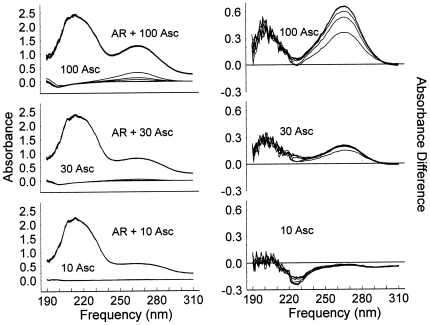
Spectroscopic measurements of ascorbate-human adrenergic receptor binding.The figures on the left show the superimposed records of six spectra collected 118, 141, 155, 188, 199, and 228 minutes after the samples were prepared. Samples with both AR and ascorbate are indistinguishable from one another and do not change over time, while the ascorbate alone samples show ascorbate oxidation and a decrease in absorbance in the 266 nm range. The difference spectra in the right hand column show an ascorbate concentration dependent increase between 190 and 210 nm, an absorbance decrease between 220 and 230 nm at 10 µM ascorbate, and the difference between the oxidizing ascorbate solutions without AR and the non-oxidizing ascorbate with AR in the 260–270 nm range.